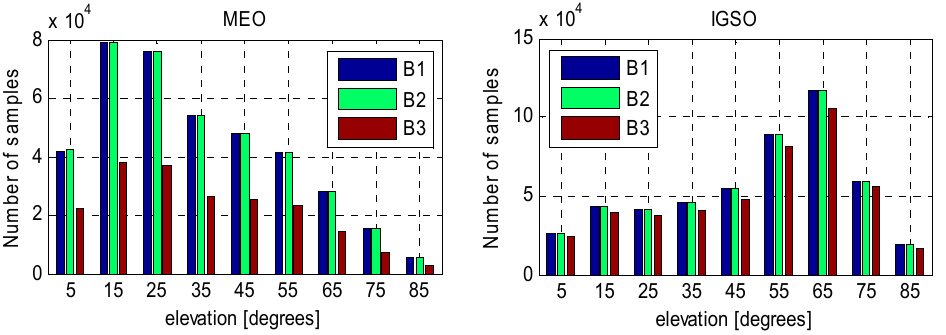
Figure 3. Number of MP samples against elevation bins with an interval of 10° for BeiDou MEO ( left ) and IGSO satellites ( right ).